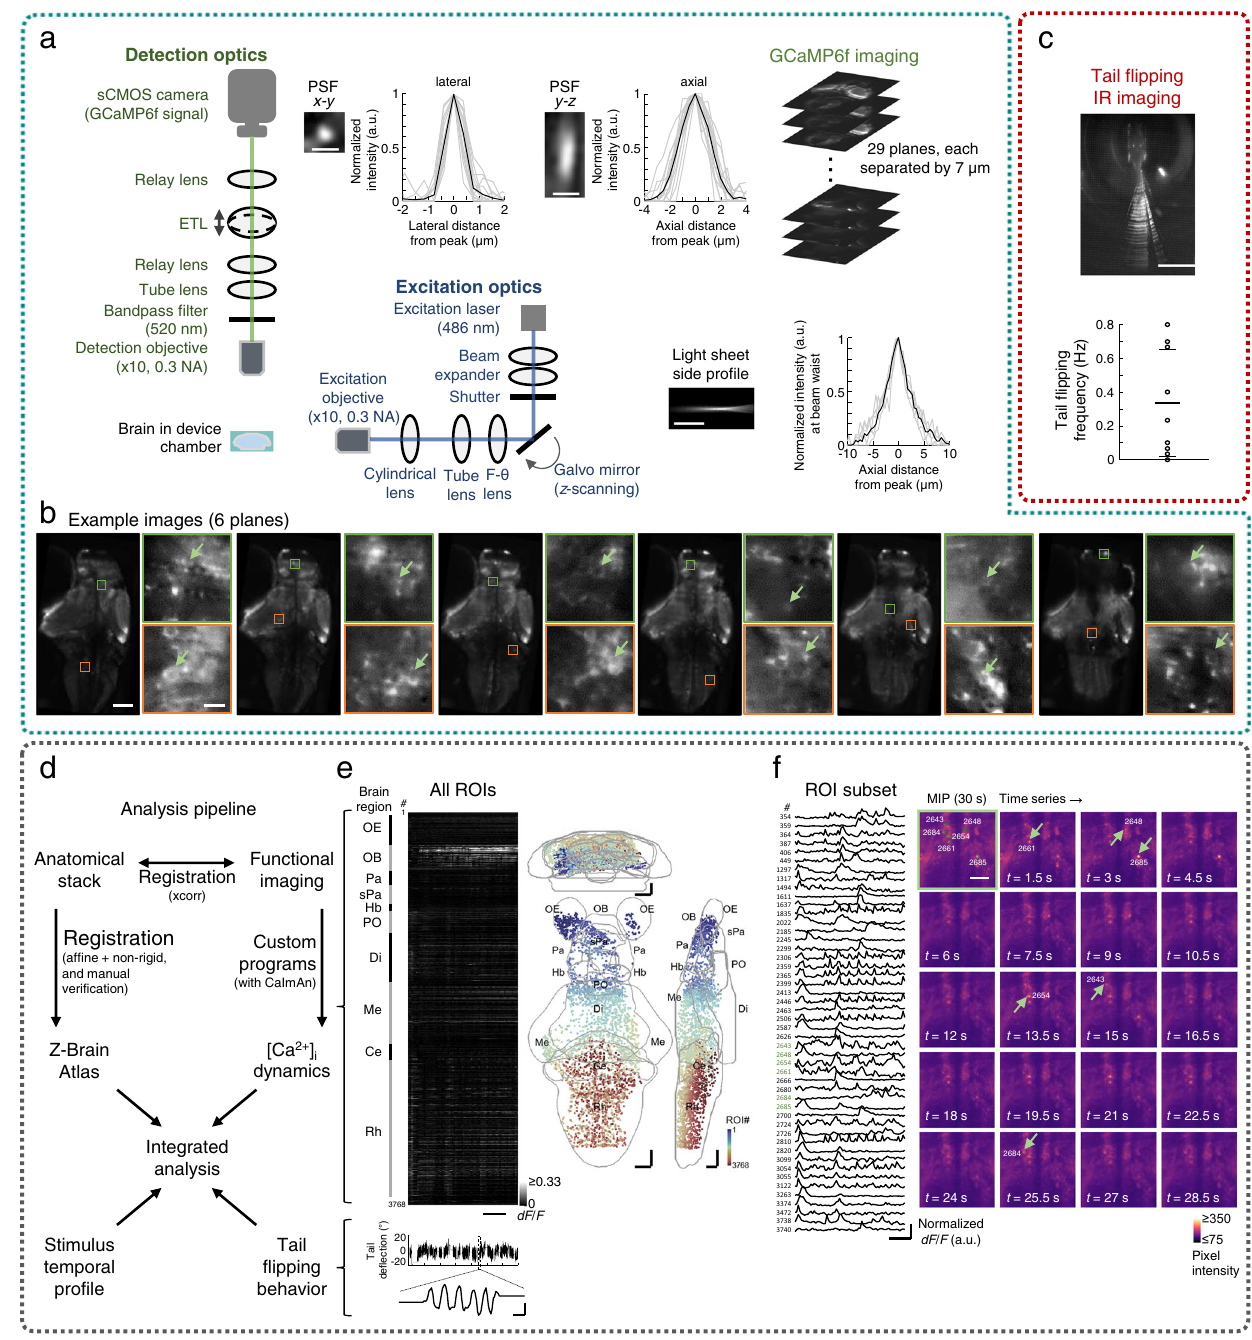
Fig. 3 | An integrated opto fl uidic system for in vivo imaging of chemosensory- evoked neuronal activity and behavior. a The micro fl uidic ( µ fl uidic) module is integratedwithascanninglightsheetmicroscopeforwhole-brainimaginginlarval zebra fi sh. Inset image/plot sets show characterization of the excitation and detection arms (see “ Methods ” ). Each set includes an image showing one example pro fi leandaplotofpro fi les(gray:individual;black:mean),forthelateral( x – y )and axial ( y – z ) point spread functions (PSFs, scale bars: 2 μ m), and the light sheet side pro fi le(scalebar:50 μ m). b Exampleimageplanes.Foreachset,thetwoimageson the right are enlarged and contrast-adjusted from the outlined areas of the corre- spondinglargerimages.Scalebars:100 μ mforthelargerimagesand10 μ mforthe zoomed-in images. Arrows indicate example neurons at various brain locations. c Upperpanel:temporallyoverlaidtailimagesofanexamplelarva(scalebar:1mm). Lowerpanel:spontaneoustail fl ipping frequency of9 larvaethatwerebehaviorally active. Horizontal lines indicate mean ±1SD. d Work fl ow of the custom-developed data analysis pipeline. e Brainwide spontaneous activity heatmap and region-of-